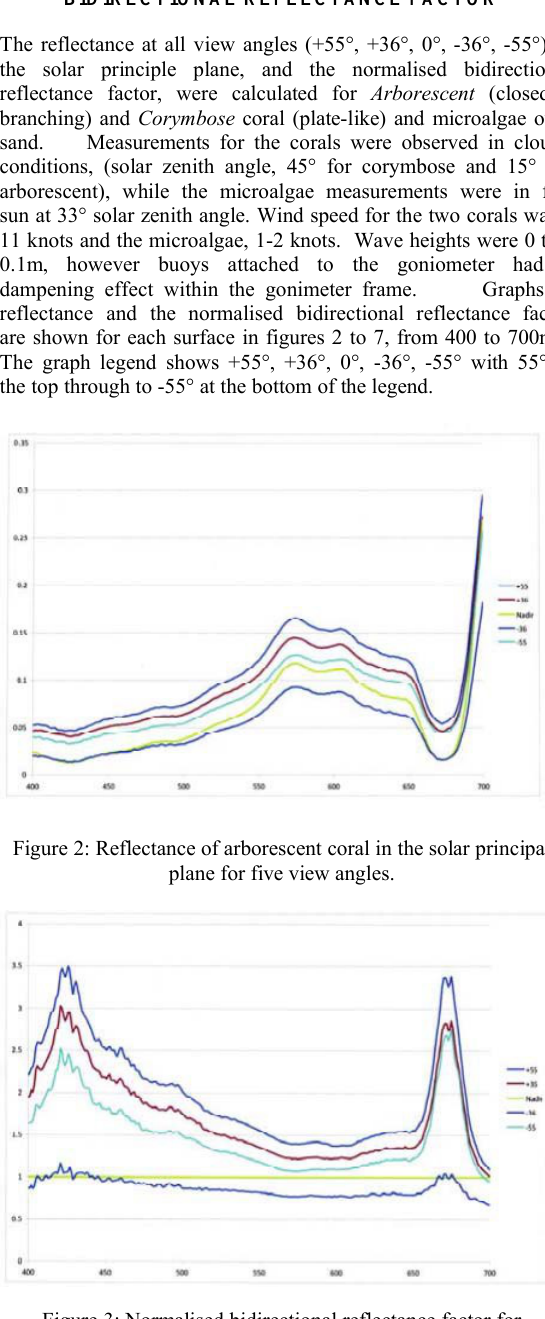
Figure 3: Normalised bidirectional reflectance factor for arborescent coral - solar principal plane for five view angles.